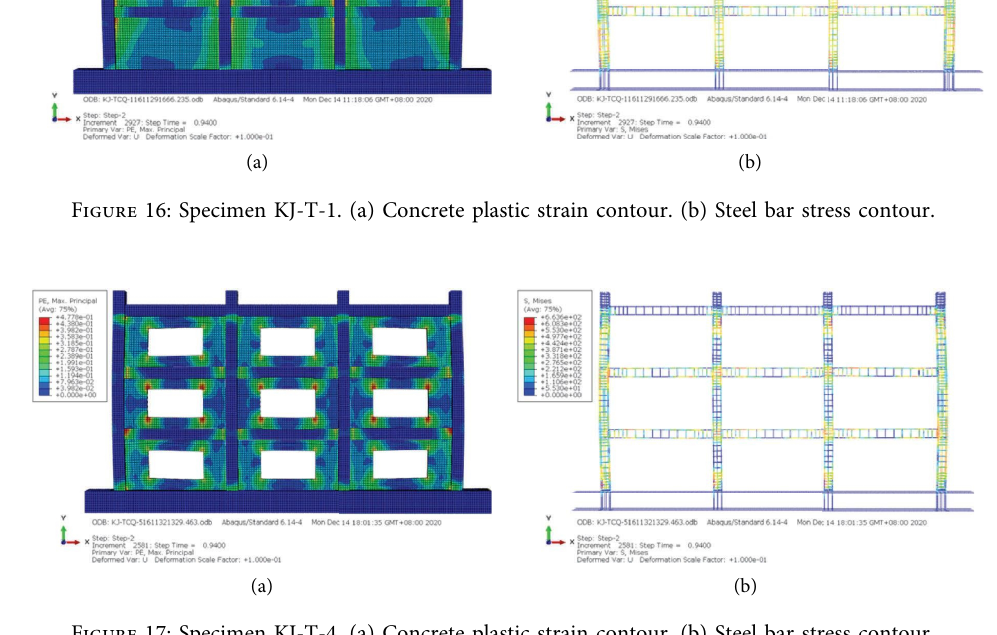
Figure 17: Specimen KJ-T-4. (a) Concrete plastic strain contour. (b) Steel bar stress contour.